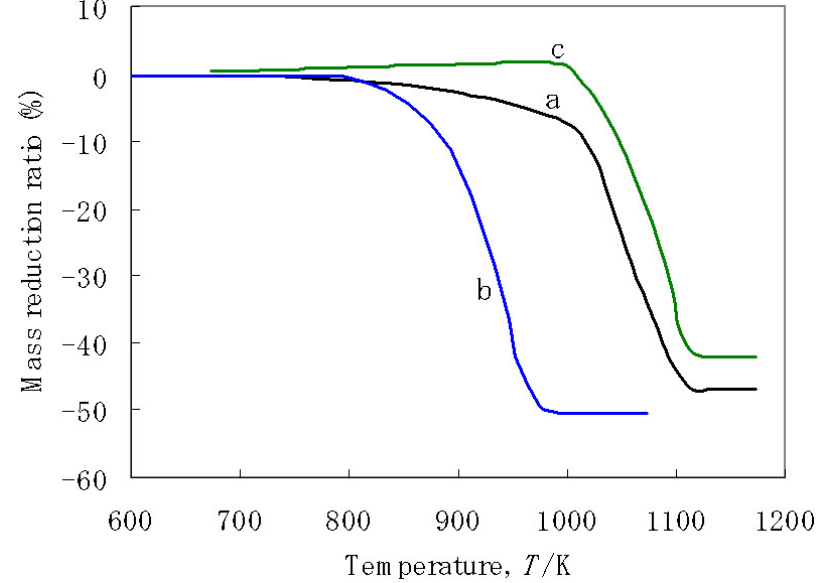
Figure 5. thermogravimetric (TG) curves of foaming agents: ( a ) dolomite; ( b ) MgCO ( c ) CaCO 3